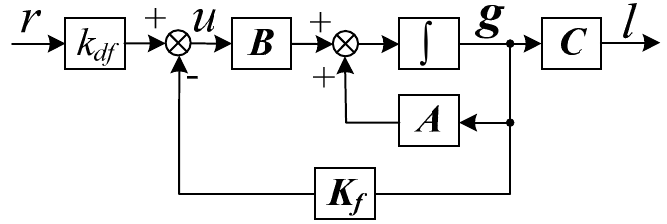
Figure 10. Three-state feedback control block diagram.